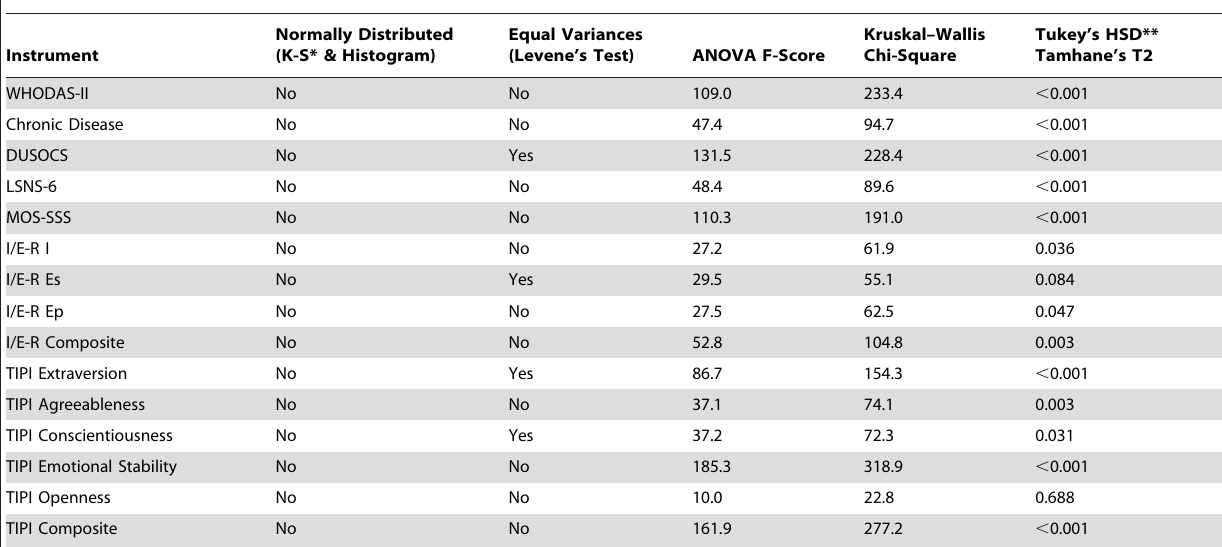
Table 2. Comparison between instruments measuring disability from chronic illness, level of social support, religiosity, and